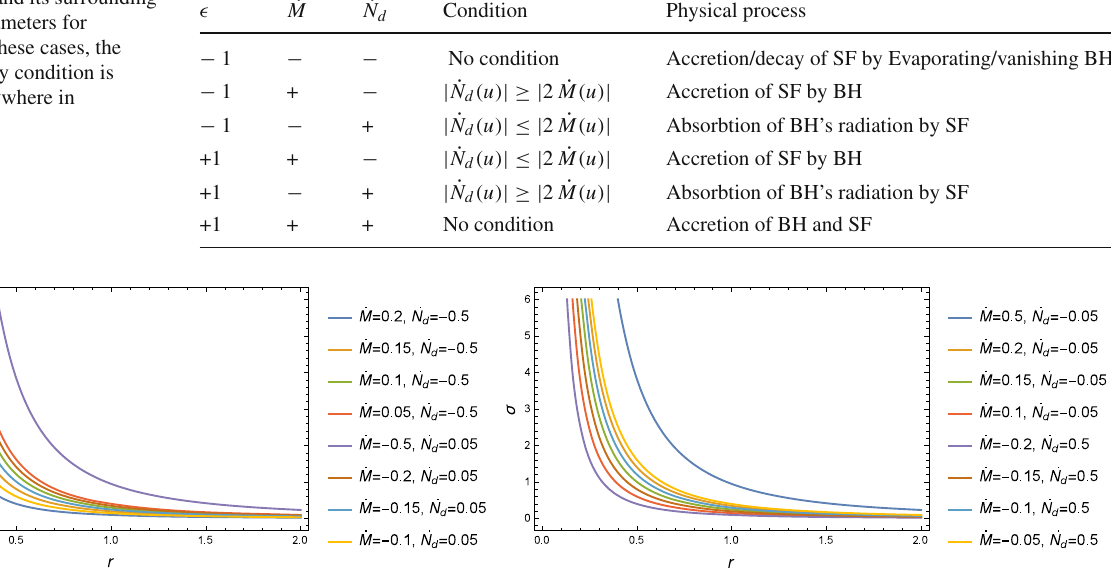
accretion density σ versus the distance r for some typical constant values of ˙ M and ˙ N d for (cid:5) = + 1 in the dust background. The four upper cases and the four lower cases correspond to the conditions | ˙ N ( u ) | ≤ | 2 ˙ M ( u ) | and | ˙ N ( u ) | ≥ | 2 ˙ M ( u ) | , respectively. By these d d conditions, it is clear that σ( r ) is a decreasing function but is